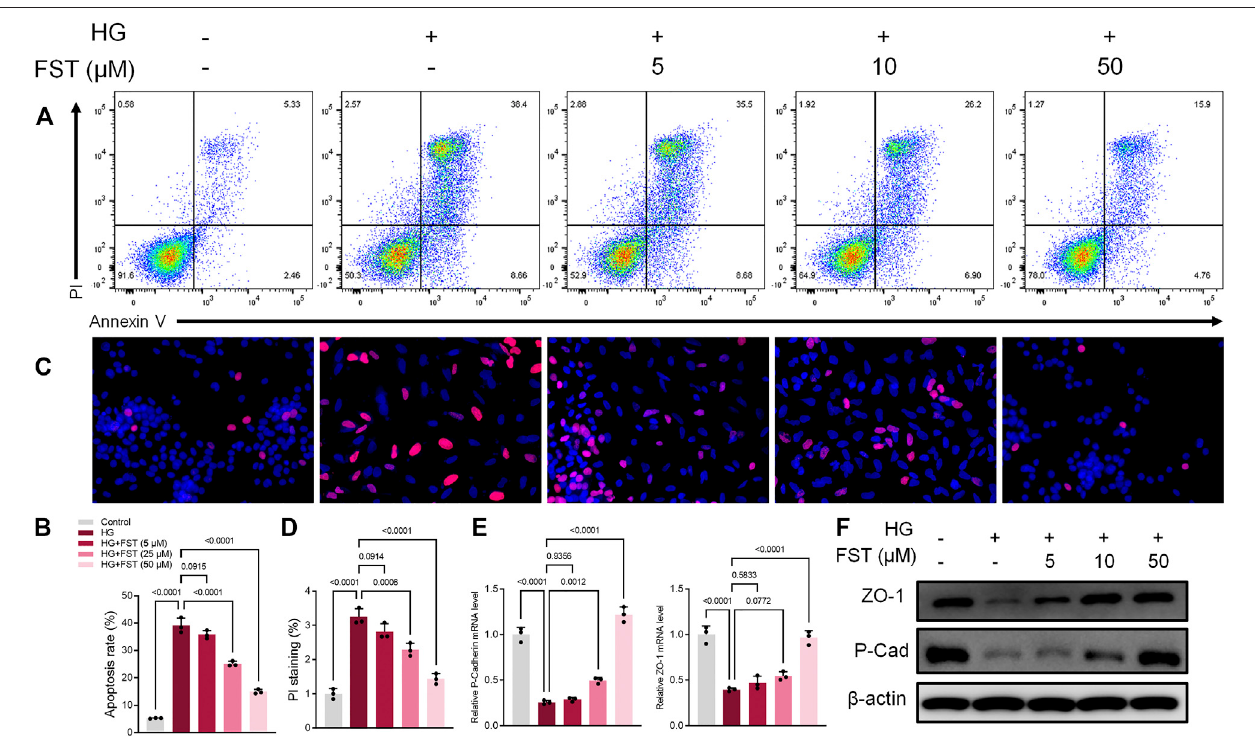
FIGURE 1 | Fisetin ameliorates high glucose-induced podocyte injury. (A,B) Quanti fi cation and analysis of apoptosis rates using fl ow cytometry in podocytes after treatment with fi setin and culturing in high glucose concentrations (30 mM) for 48 h. (C,D) Quanti fi cation and analysis of podocytes using propidium iodide (PI) staining aftertreatmentwith fi setinandculturinginhighglucoseconcentrations(30 mM)for48 h.RedindicatesPIstainingwhileblueindicatesDAPIstaining. (E,F) Determination of the expression levels of P-cadherin and ZO-1 in podocytes using real-time quantitative reverse transcription polymerase chain reaction (qRT-PCR) and western blot after treatment with fi setin, and culturing in high glucose concentrations (30 mM) for 48 h. Data are expressed as means ± SEM ( n = 3).